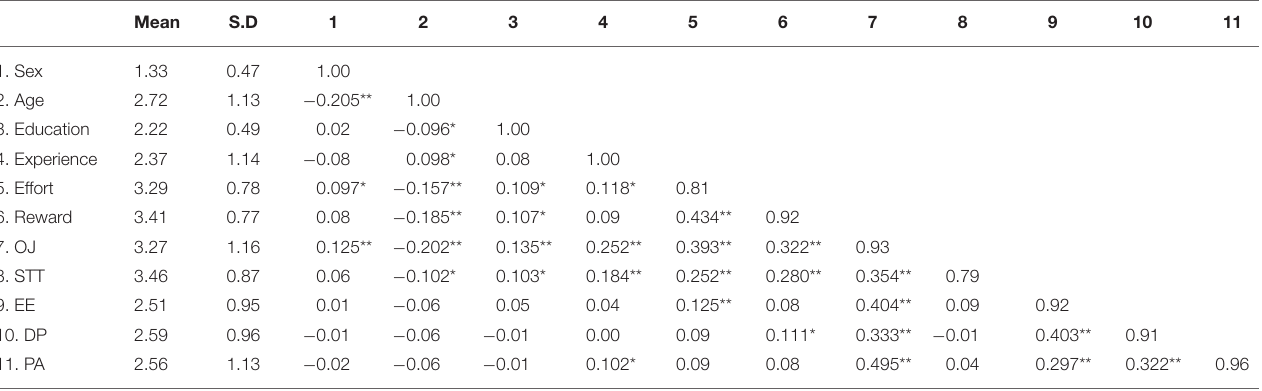
TABLE 1 | Mean, standard deviations, correlations, and reliabilities.